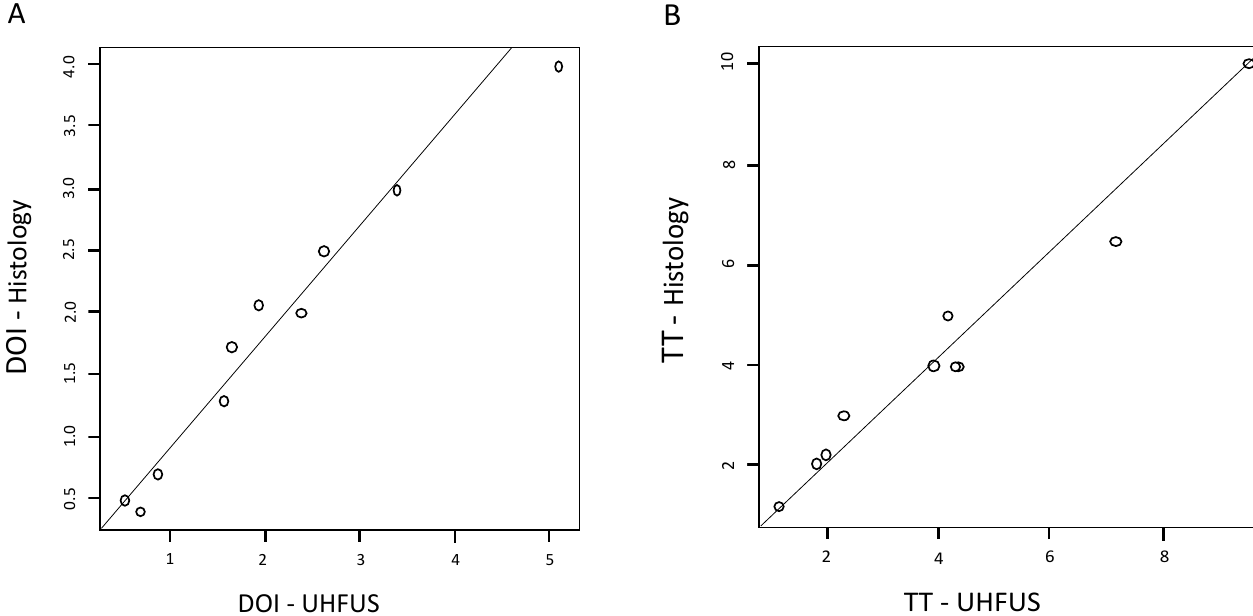
Figure 4. Scatterplot showing the correlation between DOI ( A ) and TT ( B ) estimated by means of UHFUS and histology. The dots represent individual patients and their combination of UHFUS and histology values of DOI and TT.